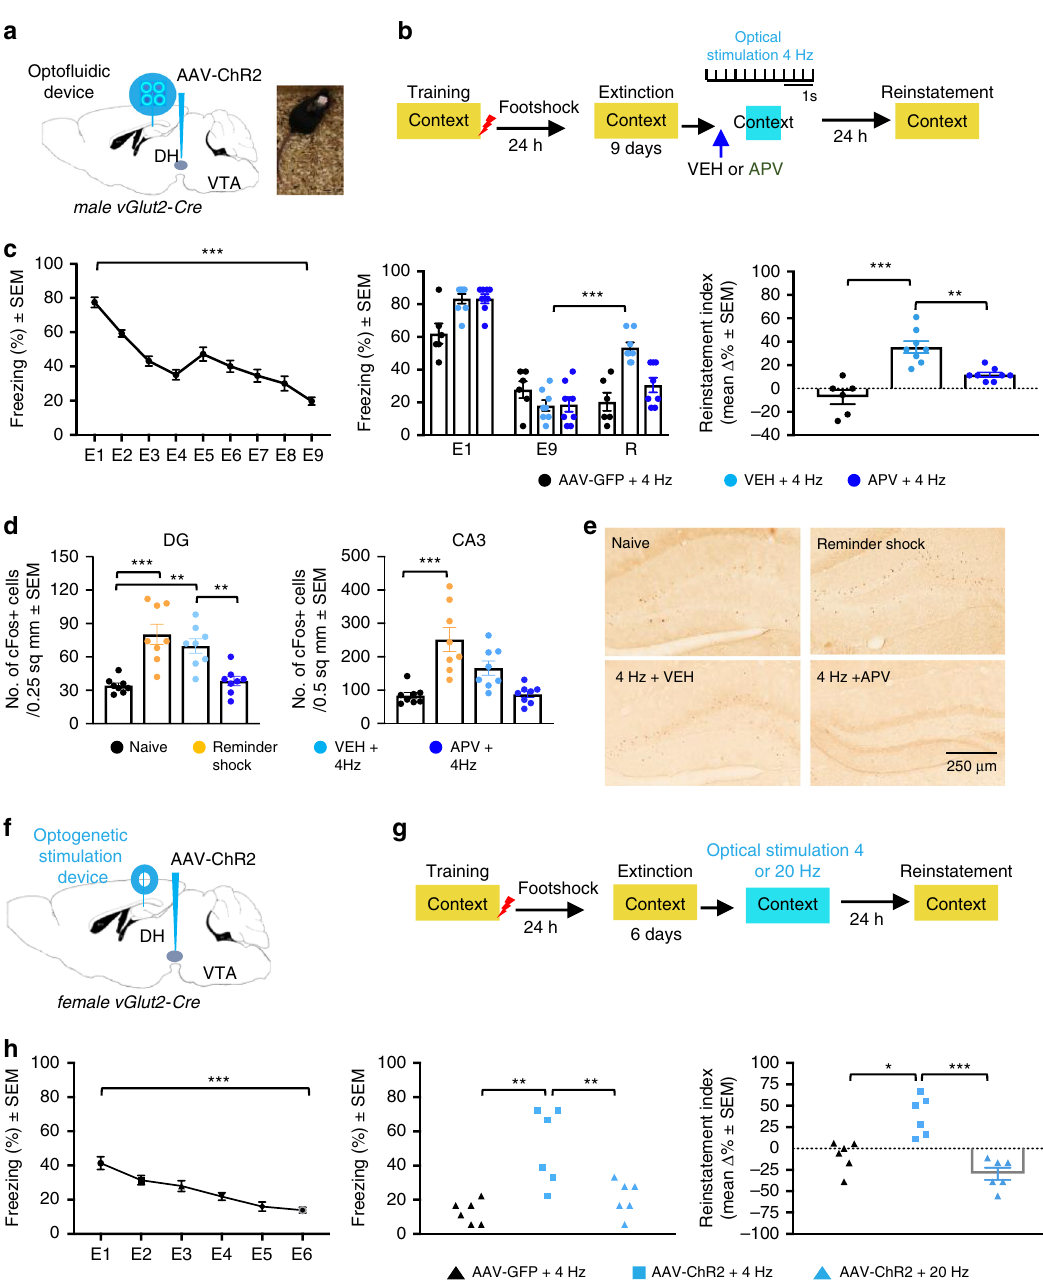
Fig. 4 Optogenetic stimulation of vGlut2 VTA → DH terminals triggers fear reinstatement. a Virus infusion into VTA and implantation of opto fl uidic device in DH of vGlut2-Cre males. b After extinction, mice were injected with VEH ( n = 8) or APV ( n = 8) 20 min before receiving tonic 4 Hz stimulation. c Left, extinction [RM one-way ANOVA for all mice, F (3.688, 77.45) = 43.19, *** P < 0.0001]. Middle, fear reinstatement after optogenetic stimulation. Two- way ANOVA revealed signi fi cant Stimulation effect [ F (2, 57) = 9.166, P = 0.0004], Test × Stimulation interaction [left, F (4, 57) = 8.404, P < 0.0001], and reinstatement in the VEH-4 Hz group (*** P < 0.0001). Right, increased reinstatement index in VEH but not APV or control virus ( n = 6) groups [two-way ANOVA, F (2, 19) = 21.96, P < 0.0001, ** *P < 0.0001 VEH-4 Hz vs. AAV-GFP-4 Hz, ** P = 0.0029 VEH- 4 Hz vs. APV-4 Hz]. d Upregulation of cFos in DG [ n = 8/group, two-way ANOVA, F = 14.05, P < 0.0001,, *** P < 0.0001 naïve vs. reminder shock, ** P = 0.0016 naïve vs. VEH-4 Hz, ** P = 0.0055 VEH-4 (3, 28) Hz vs. APV-4 Hz] and CA3 [two-way ANOVA, F (3, 28) = 13.16, P < 0.0001, *** P < 0.0001 naïve vs. reminder shock]. e Illustration of cFos labeling. f Virus infusions and implantation of optostimulator devices in vGlut2-Cre females. g DH stimulation with 4 ( n = 6) or 20 ( n = 6) Hz for 1 min. h Left, extinction [RM one-way ANOVA for all mice, F (2.866, 48.72) = 20.11, *** P < 0.0001]. Middle, fear reinstatement after stimulation of vGlut2 VTA → DH terminals with 4 ( n = 6) but not 20 Hz ( n = 6) in ChR2 but not GFP ( n = 6) groups [one-way ANOVA, F (2,15) = 11.27, P = 0.0010, ** P = 0.0011 AAV-ChR2-4 Hz vs. AAV- GFP-4 Hz, ** P = 0.0081 AAV-ChR2-4 Hz vs. AAV-ChR2-20 Hz). Right, reinstatement index [one-way ANOVA, F ((2, 15) = 19.32, P < 0.0001, * P = 0.023 AAV-ChR2-4 Hz vs. AAV-GFP-4 Hz, *** P < 0.0001 AAV-ChR2-4 Hz vs. AAV-ChR2-20